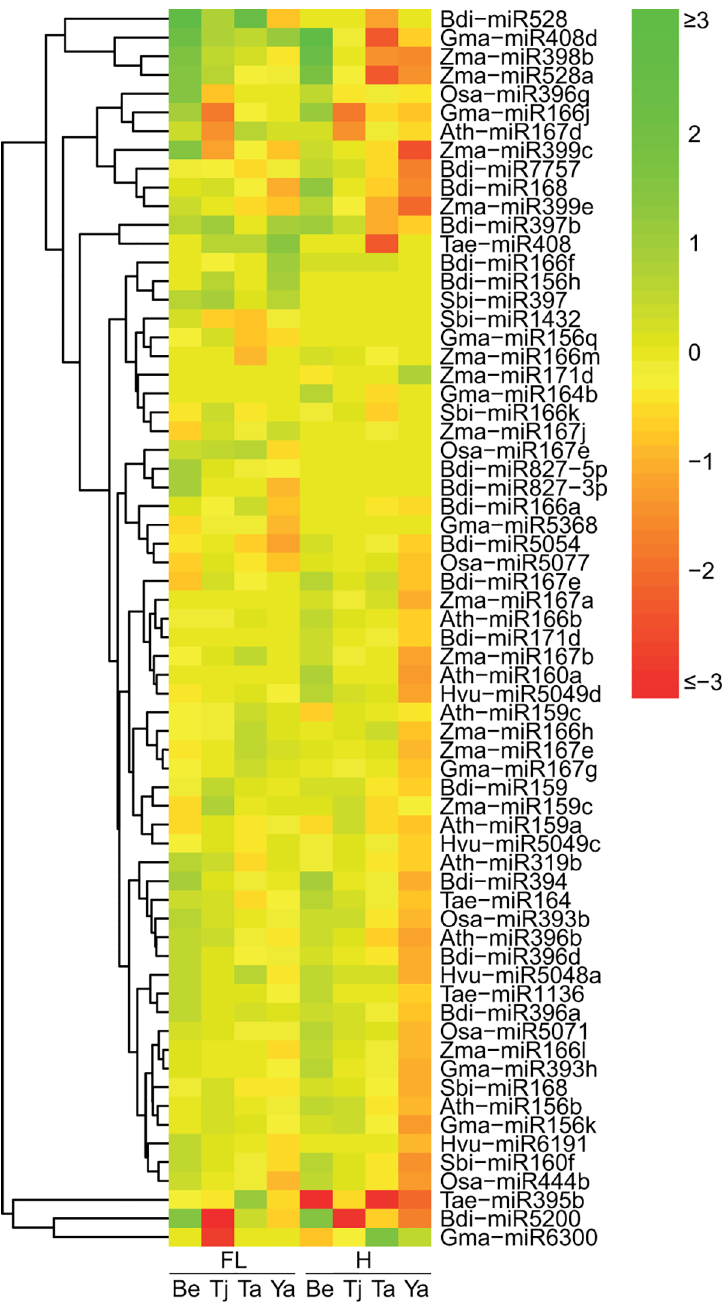
Fig 3. Heat-map showing expression patterns of water deficit stress responsive conserved miRNAs revealed by high-throughput sequencing. The colour scale is based on the log2 value of the fold-change of the water deficit stress treatment libraries compared to the control treatment libraries in four durum genotypes. Log2 value = log2 (RPM of miRNA reads in water deficit stress libraries/RPM of miRNA reads in to control libraries). The red colour indicates that the miRNA was more abundant in the control libraries; while the green colour indicates that the miRNA was more abundant in the water deficit treatment libraries. CG = Control group; WG = Water deficit stress group; FL = Flag leaf samples; H = Head samples; Be = EGA Bellaroi; Ta = Tamaroi; Tj = Tjilkuri; Ya = Yawa; Ath = Arabidopsis thaliana ; Bdi = Brachypodium distachyon ; Hvu = Hordeum vulgare ; Gma = Glycine max ; Osa = Oryza sativa ; Sbi = Sorghum bicolor ; Tae = Triticum aestivum ; Zma = Zea mays .